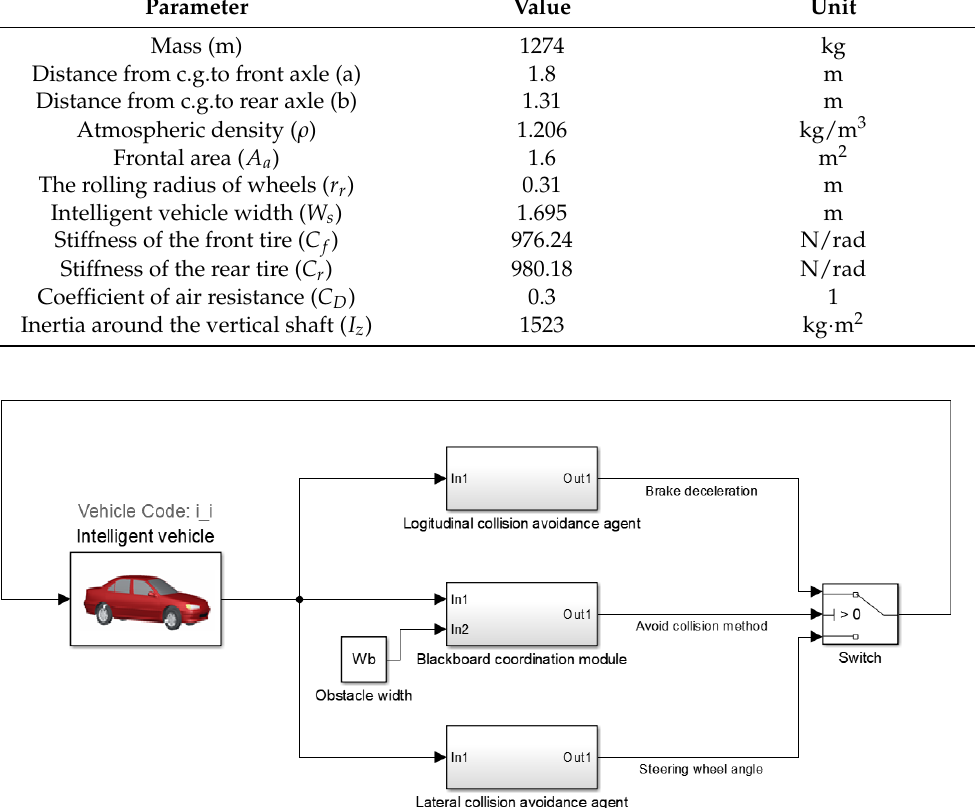
Figure 7. Distributed multi-agent collision avoidance system simulation.